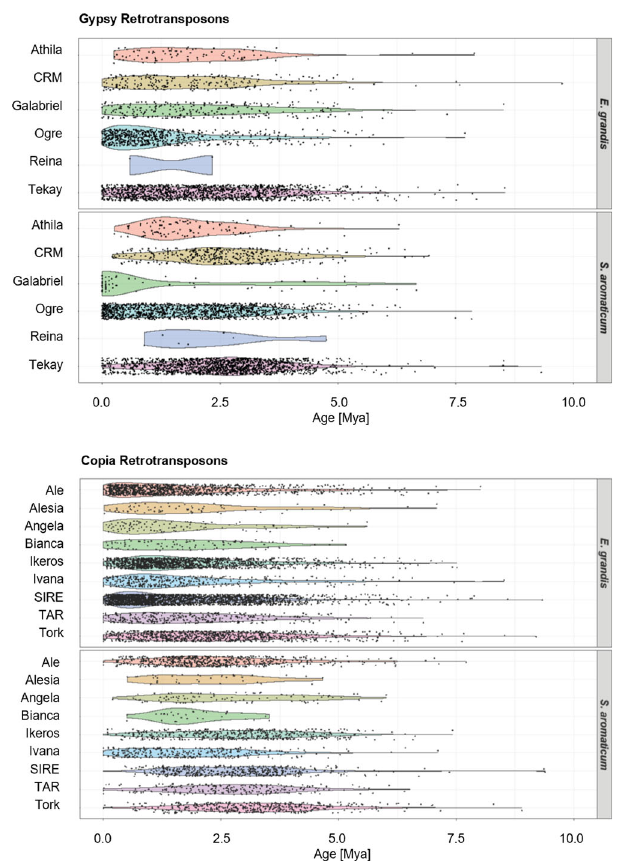
Fig. 2 Estimation of LTR-RTs element insertion time. The top panel shows the insertion time of Gypsy lineages in E. grandis and S. aromaticum , and the bottom panel shows the insertion time of Copia lineages in E. grandis and S. aromaticum . Only lineages detected in both species are